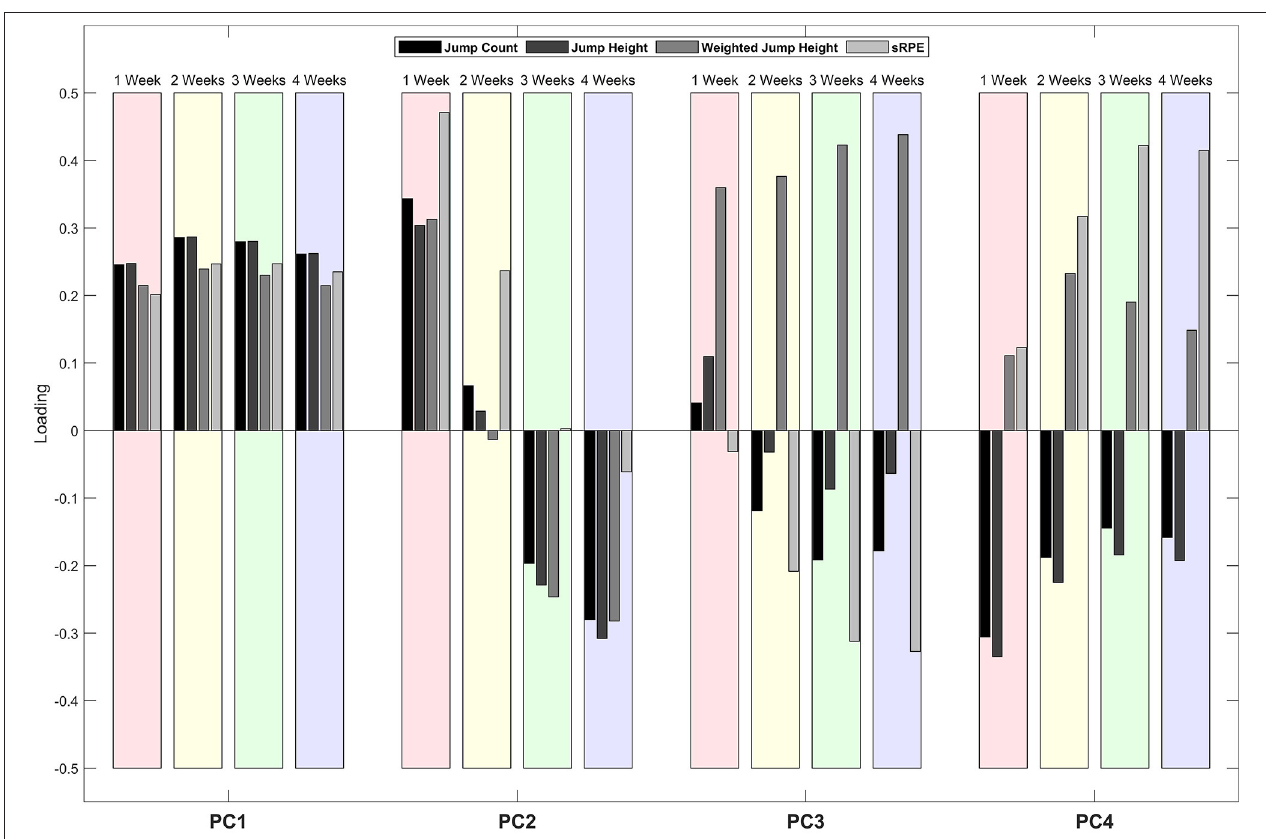
FIGURE 7 | Loading of each workload variable (jump count, jump height, weighted jump height, and sRPE) and accumulation (previous 1-, 2-, 3-, and 4-week workloads) on each of the retained PCs. A positive value for loading indicates a positive association between the workload variable and the PC. Variables with a higher loading magnitude indicate a stronger association with the